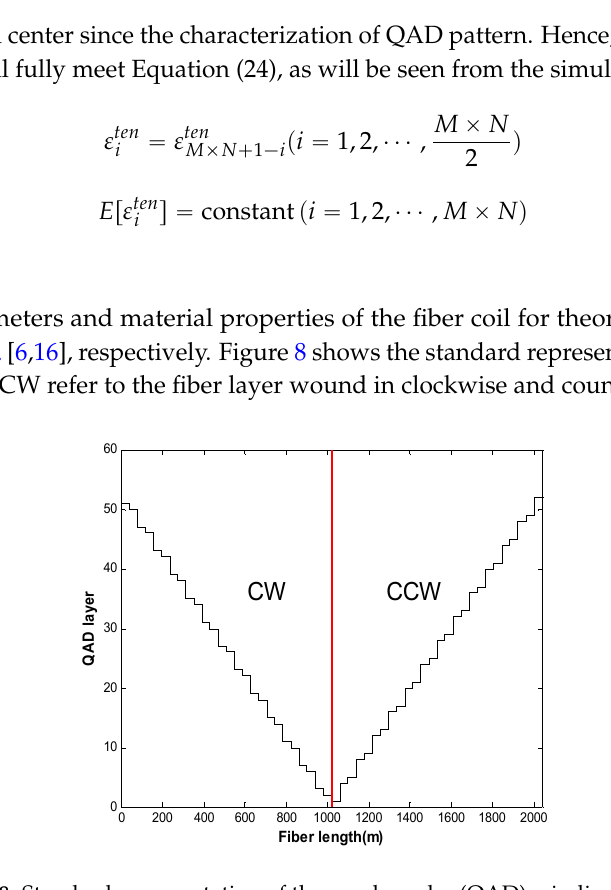
Figure 8. Standard representation of the quadrupolar (QAD) winding pattern. Table 1. Geometric parameters.